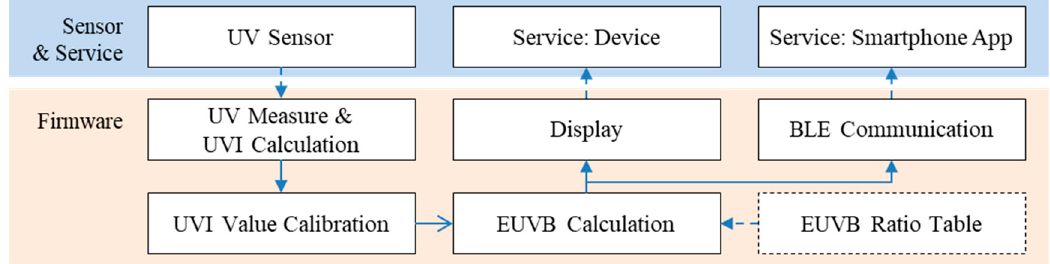
Figure 5. The main process flow of the firmware.